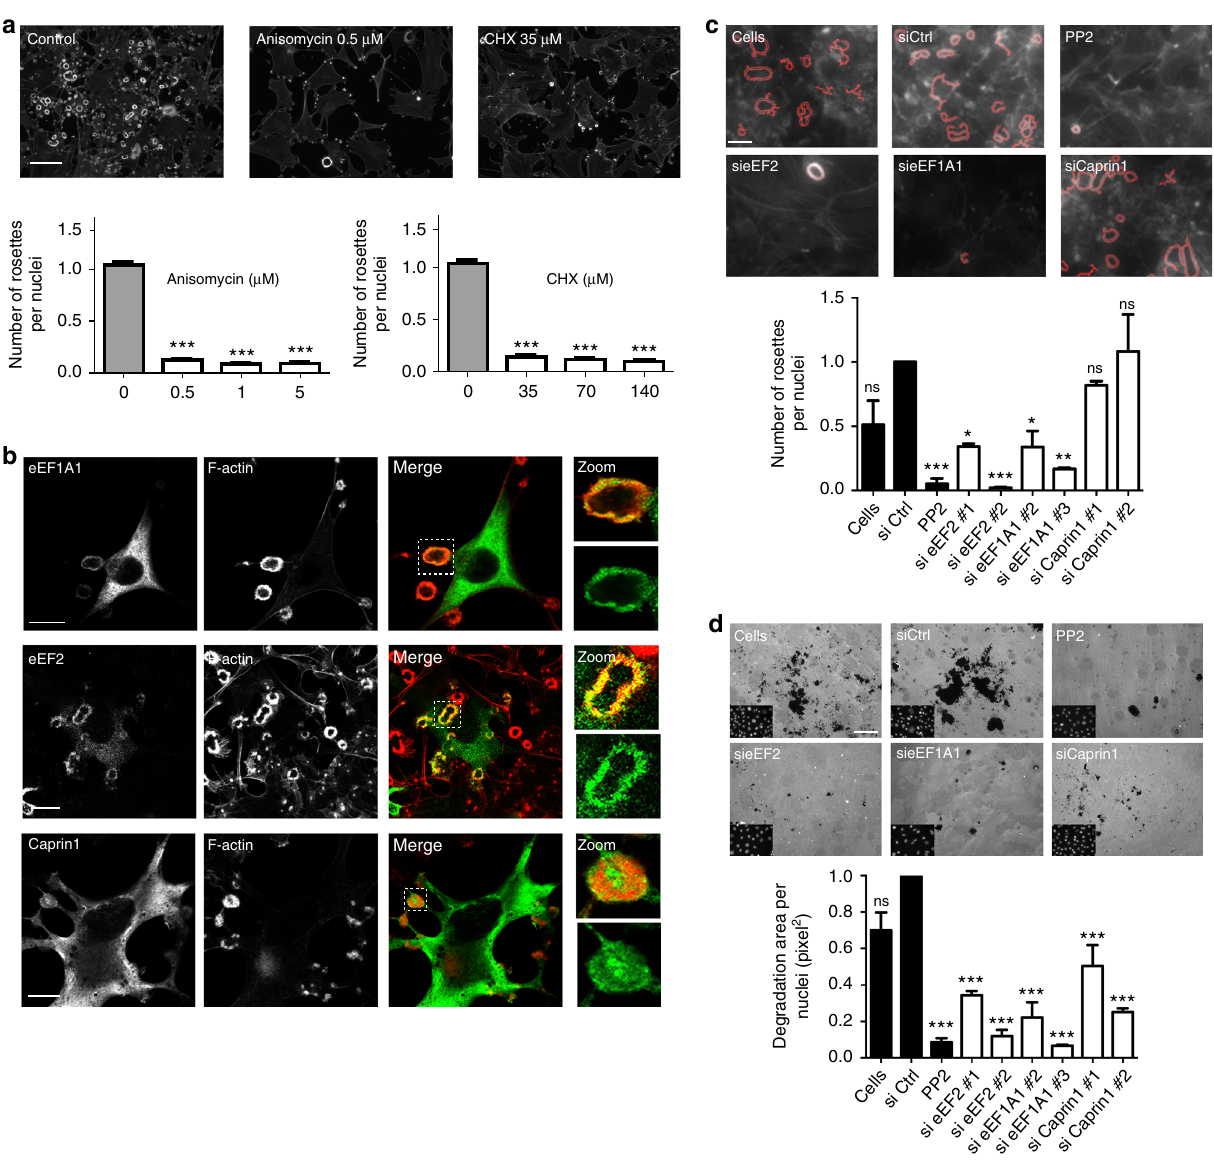
Fig. 3 Localization and involvement of translation-related proteins at invadosomes. a Dose response of the number of rosettes per nuclei after translation inhibitor treatment. NIH-3T3-Src cells were treated with anisomycin or cycloheximide (CHX) for 24 h. Representatives images of cells treated the minimum concentration. The bar graph represents the number of rosettes per nuclei. Error bars (SEM, n = 20 fi elds, three independent experiments; *** P < 0.001 as compared with the non-treated cells as control, one-way ANOVA followed by Bonferroni test as compared with the siRNA control). Scale bar: 50 µ m. b Confocal microscopy images of lifeact-mRuby (red)-expressing NIH-3T3-Src cells immunostained for eEF1A1 (green) or transfected with eEF2-GFP (green) or Caprin 1-myc (green). Left panels show in each channel in black and white. Right panels show merge images with enlarged views of the boxed regions. Scale bars: 10 µ m (EEF1A1 and Caprin 1), 20 µ m (eEF2). c Lifeact-mRuby (gray)-expressing NIH-3T3-Src cells were transfected with a siRNA control (siCtrl) or two independent siRNA targeting eEF2, eEF1A1, or Caprin 1 involved in translation activity. As controls the cells were treated with the Src inhibitor PP2 (5 µ M). The upper panel shows representative images of the rosette number determined by the mask applied by the software (red areas). Scale bar: 5 µ m. In the lower panel, the bar graph shows the number of rosettes per nuclei. The black bars represent the control conditions of the experiment. Error bars (SEM, n = 75 fi elds, three independent experiments; ns, not signi fi cant; * P < 0.05; ** P < 0.005; *** P < 0.001 by one-way ANOVA followed by Bonferroni test as compared with the siRNA control). d NIH-3T3-Src cells transfected with a siRNA control (siCtrl) or two independent siRNA targeting eEF2, eEF1A1, or Caprin 1 were seeded on a fl uorescent gelatin matrix. As a control, cells were treated with PP2 (5 µ M). The upper panel shows representative images of the degraded area (black), insets on the bottom show the nuclei of the same fi eld. Scale bar: 50 µ m. In the lower panel, the bar graph shows the gelatin area degraded per cell after 24 h. Error bars (SEM, n = 30 fi elds, three independent experiments; ns, not signi fi cant, *** P < 0.001 as compared with the control siRNA, one-way ANOVA followed by Bonferroni test as compared to the siRNA